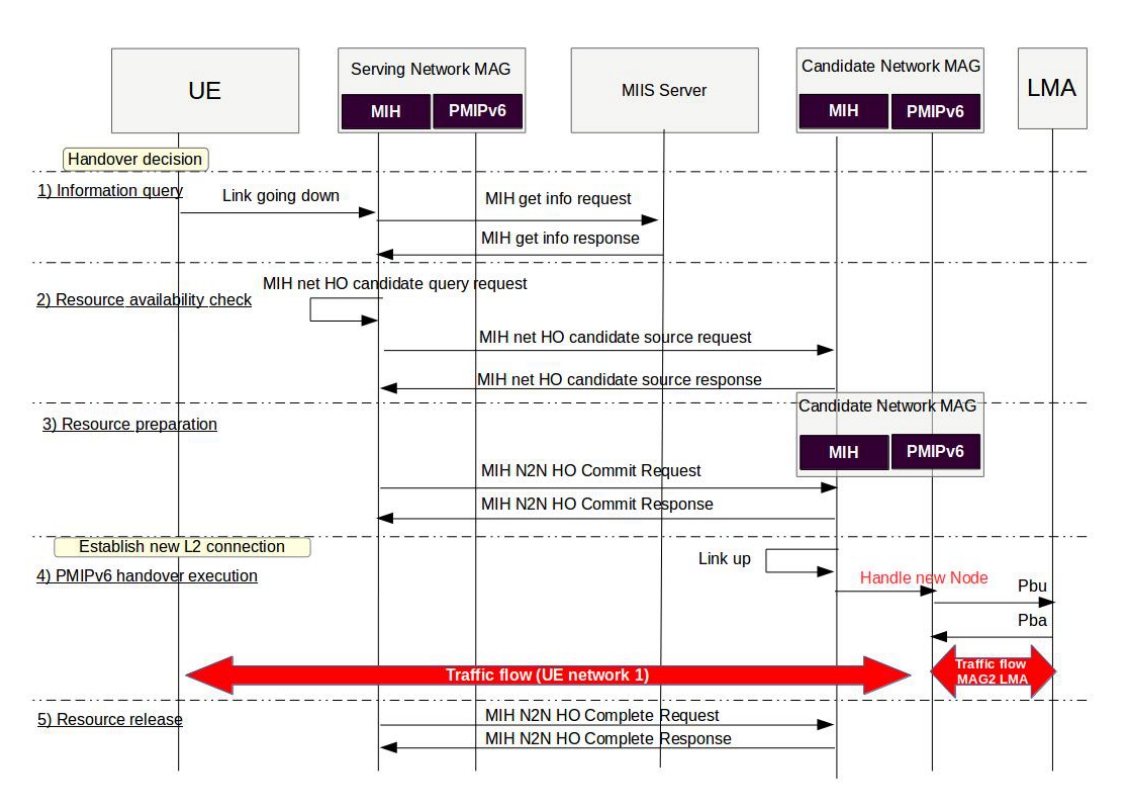
Figure 5. Operation procedure of the proposed IEEE 802.21 MIH functionality assisted by